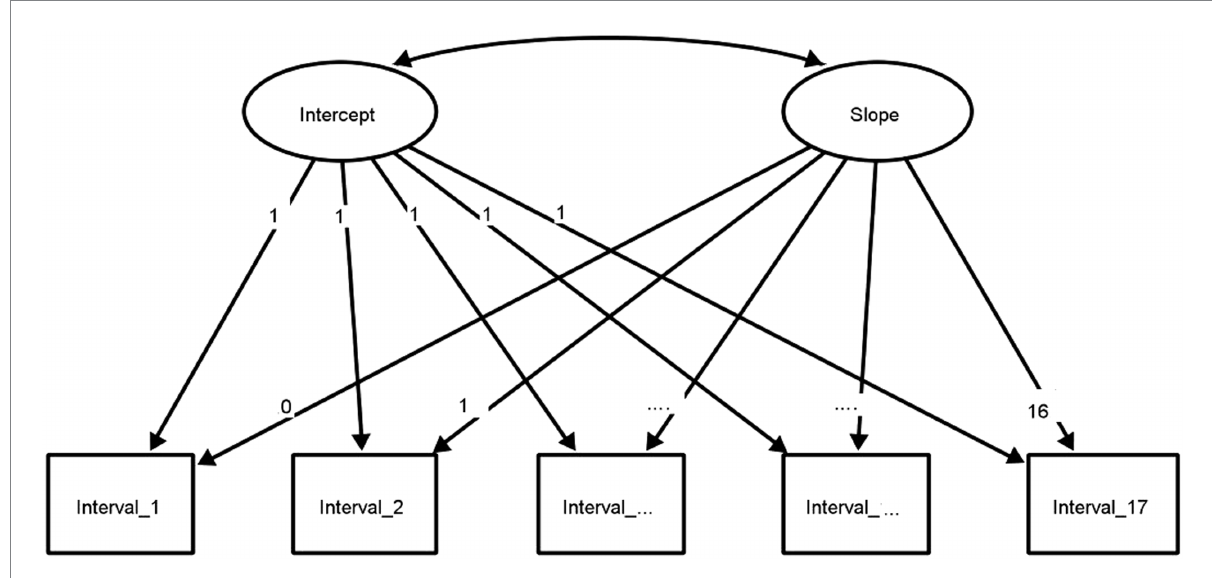
FIGURE 1 Graphical representation of a LGCM for 17 measurement intervals without covariates. The three dots represent the intervals 3–15, which were not included in this representation for greater clarity. The graphical representation of the growth model was created with Ω nyx (von Oertzen et al.,